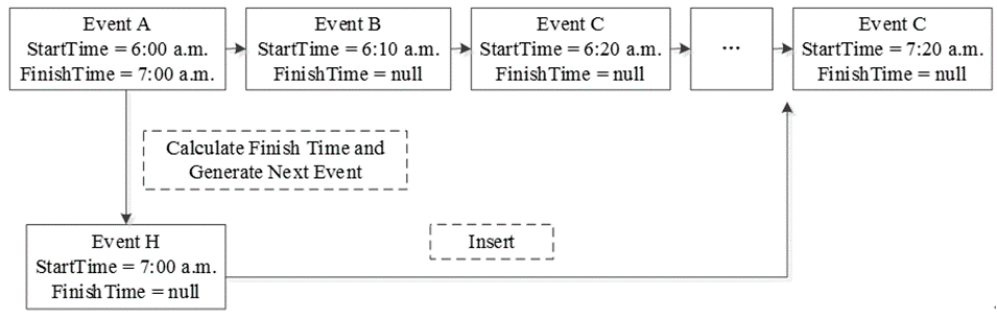
Figure 2. Sketch of the event queue in the Citizen Commuting Transportation Simulation tool (CCTSim).